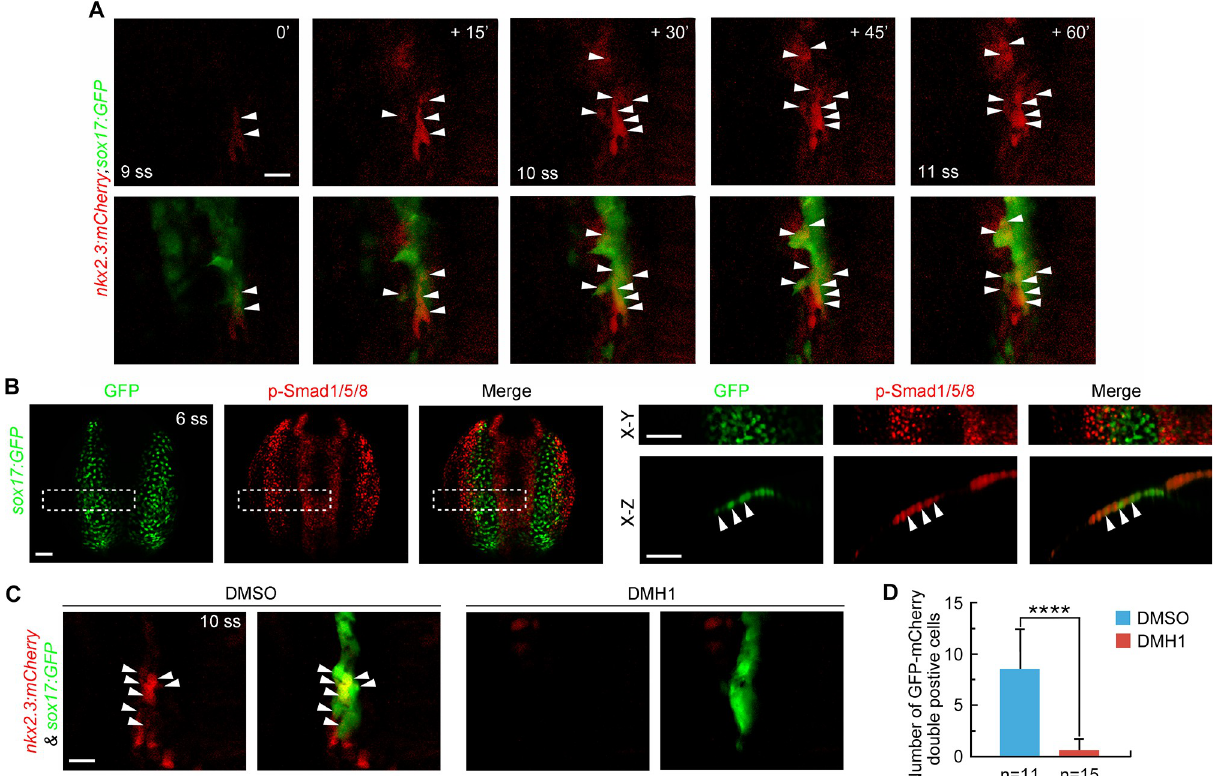
Fig 5. BMP signal is essential for pouch progenitor specification. (A) Time-lapse confocal images showing the specification of nkx2 . 3 + pouch progenitors from the pharyngeal endoderm. White arrowhead indicate the mCherry + /GFP + cells in Tg(nkx2 . 3 : mCherry;sox17 : GFP) embryos. Scale bar, 20 μ m. ( B ) Detection of p-Smad1/5/8 in Tg(sox17 : GFP) embryos at the 6-somite stage. Representative dorsal confocal images were shown in the left three panels. Boxed areas are enlarged in the right upper panels. The orthogonal sections taken from the boxed areas were shown in the right lower panels. Arrowheads indicate the endodermal cells with p-Smad1/5/8 expression. Scale bars, 50 μ m. ( C-D ) BMP signal inhibition impairs pouch progenitor specification. Tg(nkx2 . 3 : mCherry;sox17 : GFP) embryos were treated with 10 μ M DMH1 from bud stage to the 10-somite stage. Representative confocal images were shown in (C). Scale bar, 20 μ m. The number of mCherry + /GFP + cells was statistical analyzed in (D). Student’s t -test, ���� P <